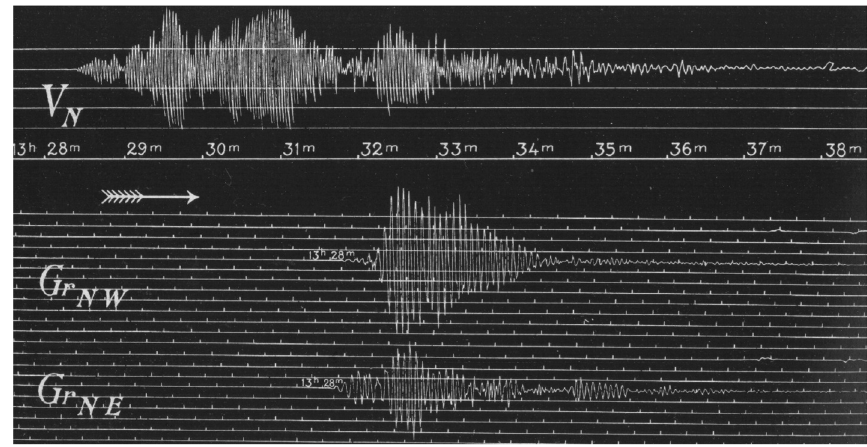
Fig. 2. Example of the recording of an earthquake which occurred in Aumale (Algeria) on June 24, 1910. V the north component of the Vicentini seismograph and Gr the Grablovitz seismograph,